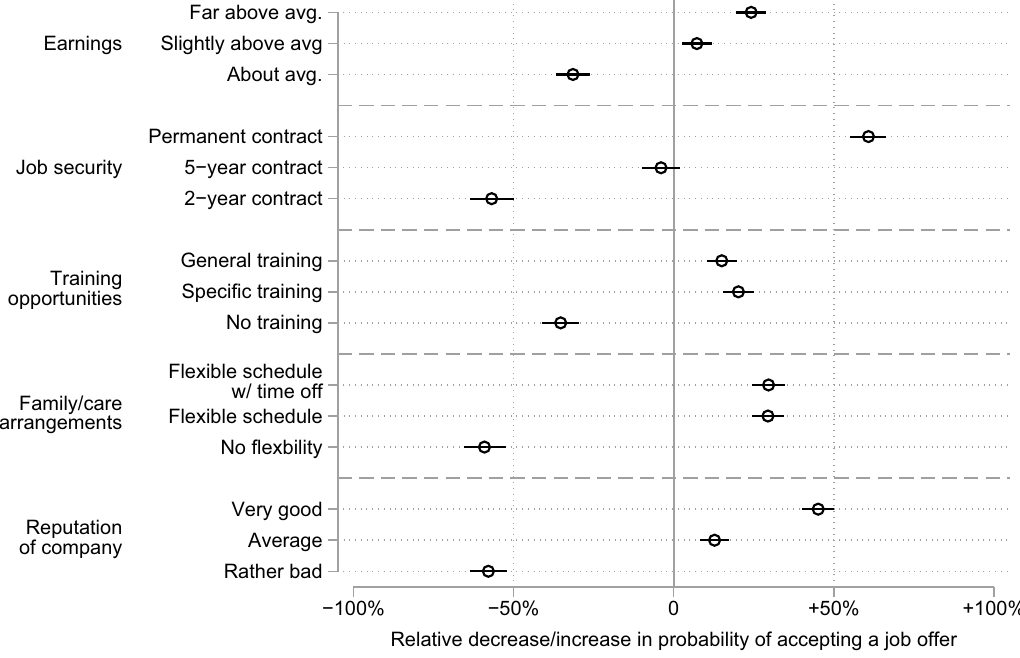
Fig 1. Preferences for job attributes among respondents in the German survey. The figure shows the relative decrease/increase in probabilities (with 95% confidence intervals) of choosing a job due to the respective job attribute.